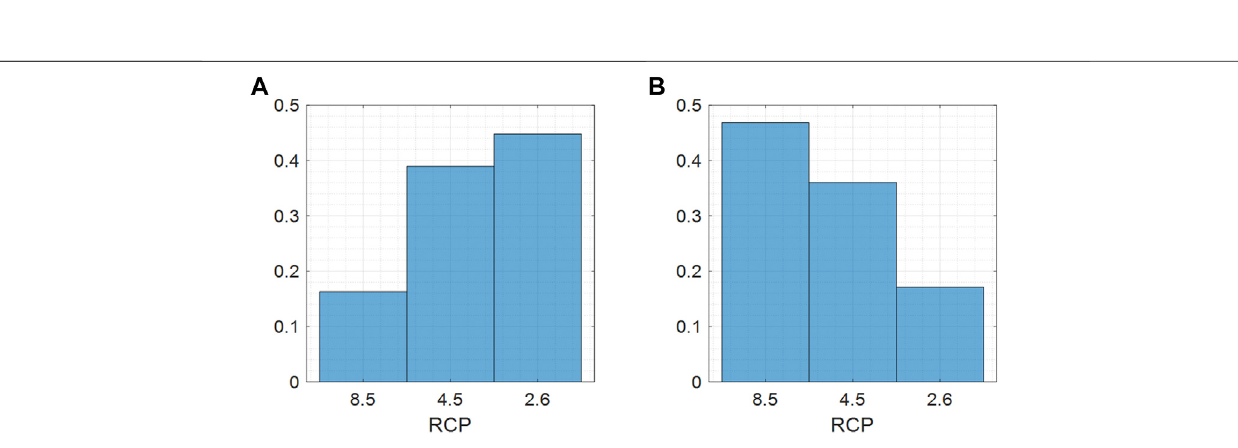
( Figure 10C ), beam ( Figure 10D ), and combined ( Figure 10E )) are de fi ned for each frame by the limit-state functions presented in Eq. 24a , Eq. 24b , and Eq. 24c , where